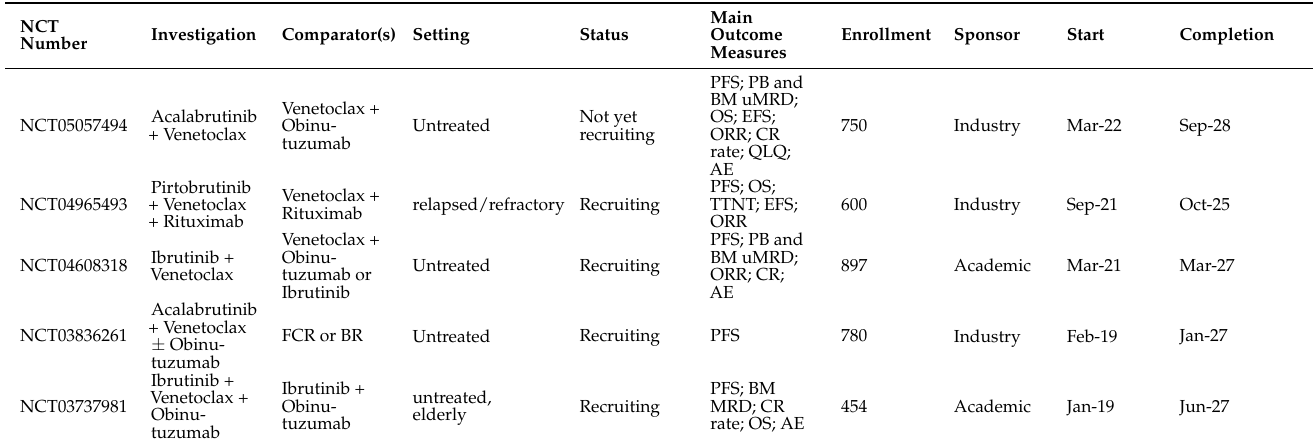
Table 1. Phase 3 clinical trials currently registered at Clinicaltrials.gov using a BTKi with a BH3- mimetic in CLL (January